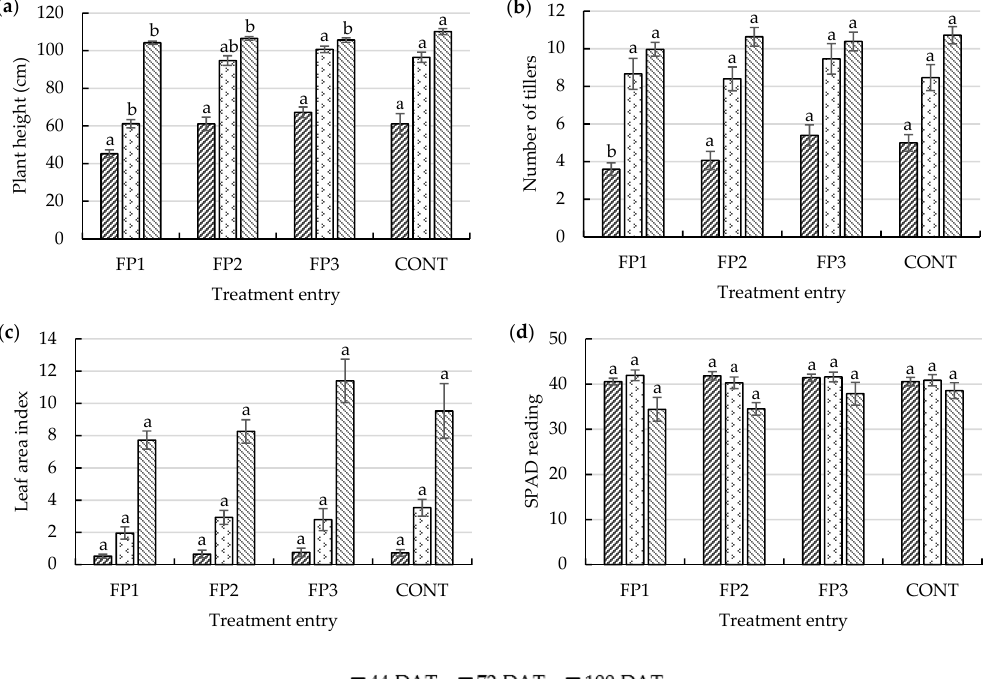
Figure 3. Effects of the four different treatments on the vegetative growth including chlorophyll measurements at 44 DAT (ATS), 72 DAT (FS), and 100 DAT (MS) under AWD. ( a ) Treatment effect on the plants height. ( b ) Treatment effect on the crops’ number of tillers. ( c ) Treatment effect on the crops’ leaf area index (LAI). ( d ) Treatment effect on the crops’ chlorophyll content according to SPAD measurements: FP1 = 0% CF + 100% PGPR, FP2 = 25% CF + 75% PGPR, FP3 = 50% CF + 50% PGPR, and CONT = 100% CF + 0% PGPR. Different letters over the error bars represent statistically different values at p ≤ 0.05 according to DMRT.